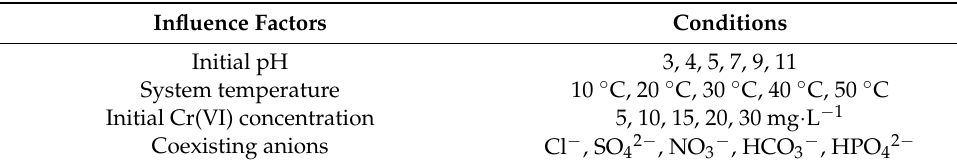
Table 1. Controlled conditions of the batch experiments (dosage of adsorbents 0.1 g L − 1 ; ultrasonic frequency 40